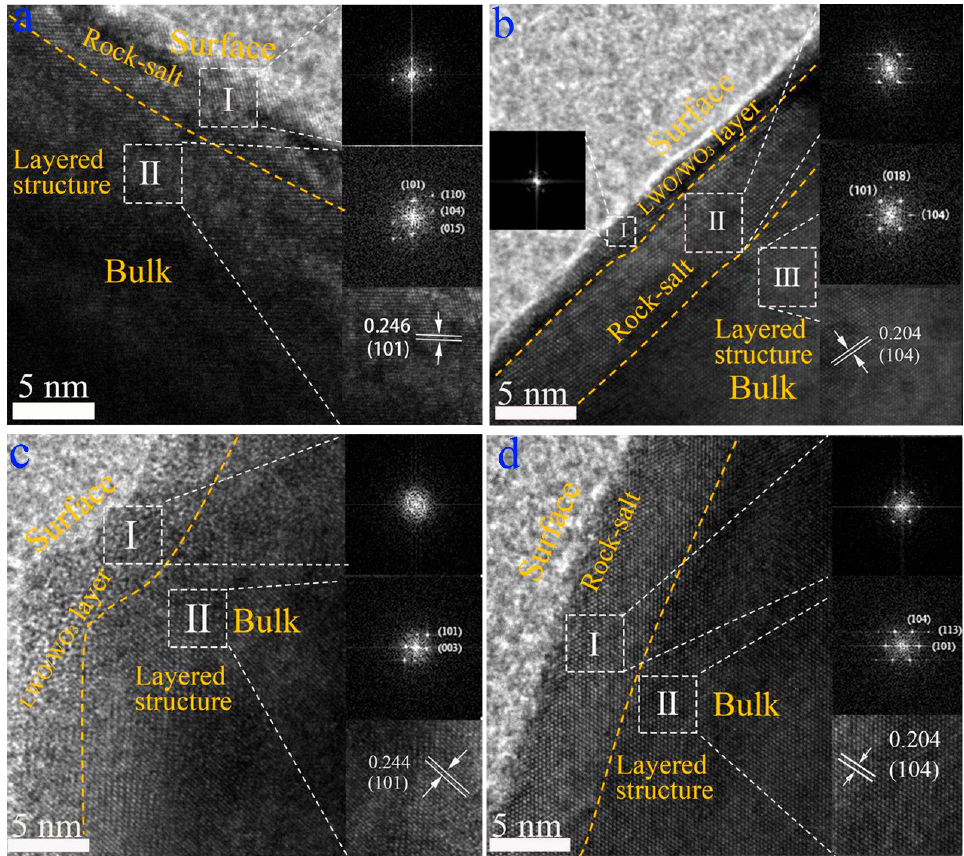
Figure 3. HRTEM images and fast Fourier transformed (FFT) images of selected areas for SC-NCM622, SC-NCM622-0.5%WO 3 , SC-NCM622-1.0%WO 3 , and SC-NCM622-1.5%WO 3 , ( a ) I: Rock-salt phase, II: Layered phase; ( b ) I: LWO/WO 3 layer, II: Rock-salt phase, III: Layered phase, ( c ) I: LWO/WO 3 layer, II: Layered phase, ( d ) I: Rock-salt phase, II: Layered phase.